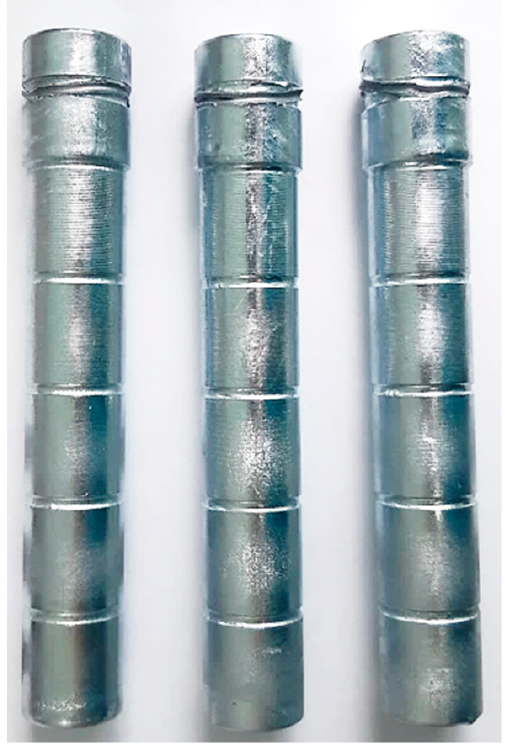
Figure 2. Hot dip galvanized parts with centrifugation.